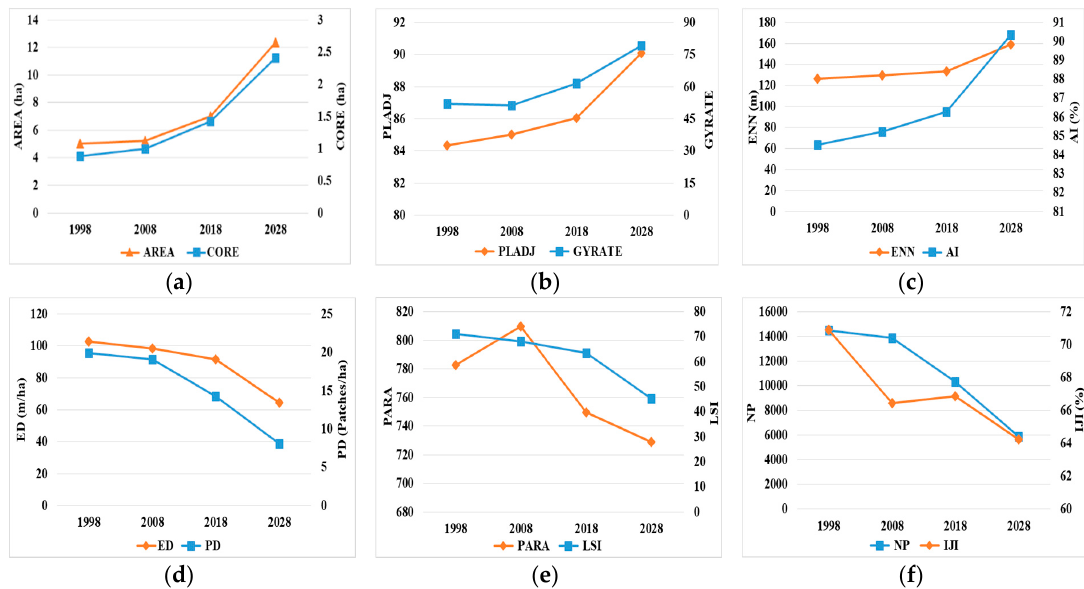
Figure 8. Different landscape level fragmentation metrics plotted over multitemporal scale for forest cover. ( a ) Mean Area (AREA) and Core Area (CORE), ( b ) Proportion of Like Adjacencies (PLADJ) and Radius of Gyration (GYRATE), ( c ) Euclidean Nearest Neighbour (ENN) and Aggregation Index (AI), ( d )Edge Density (ED) and Patch Density (PD), ( e ) Perimeter Area Ratio (PARA) and Landscape Shape Index (LSI), and ( f ) Number of Patches (NP) and Interspersion Juxtaposition Index (IJI).